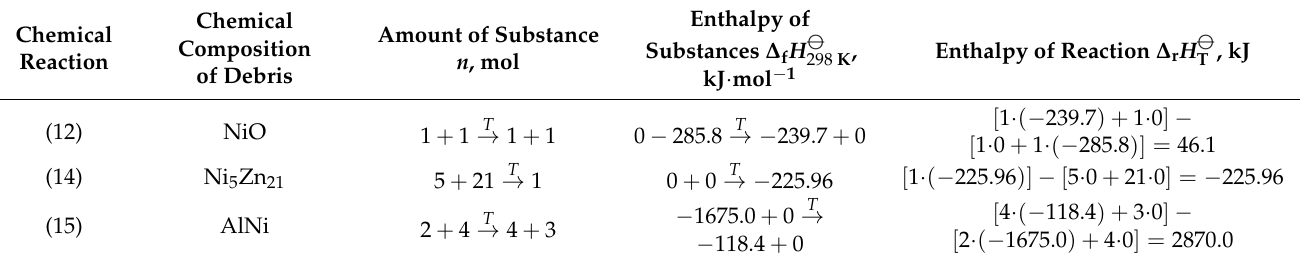
Table 14. Calculated enthalpy of formation of some Ni-containing substances. Table 15. Calculated entropy of some Ni-containing substances and equilibrium temperatures.